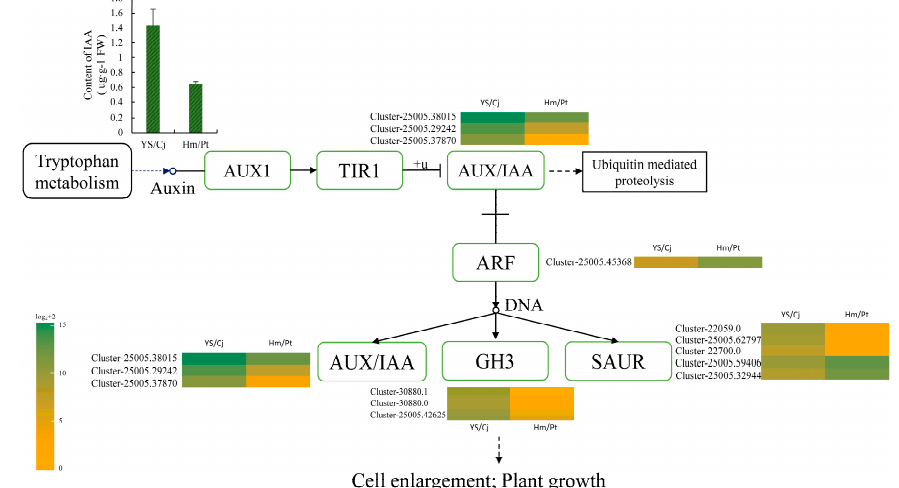
Figure 5. Overview of auxin pathways and their expression profiles and content of indole-3-acetic acid (IAA) in different graft combinations. The value of log 2 (readcount) + 2 was represented using the depth of color, with sea-green representing high expression and orange representing low expression. Note: AUX1 represent auxin resistant 1; TIR1 represent transport inhibitor response l; AUX/IAA represent auxin/indole acetic acid; ARF represent auxin response factors; GH3 represent gretchen hagen 3; SAUR represent small auxin upregulated RNA; Arrows with solid and dashed lines represent the related pathway and the abbreviated pathway, respectively.